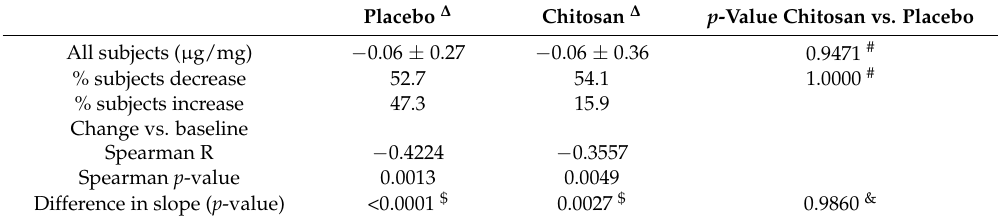
Table 8. Comparison of changes in serum R_sitosterol induced by chitosan and placebo treatments. Placebo ∆ Chitosan ∆ p -Value Chitosan vs.